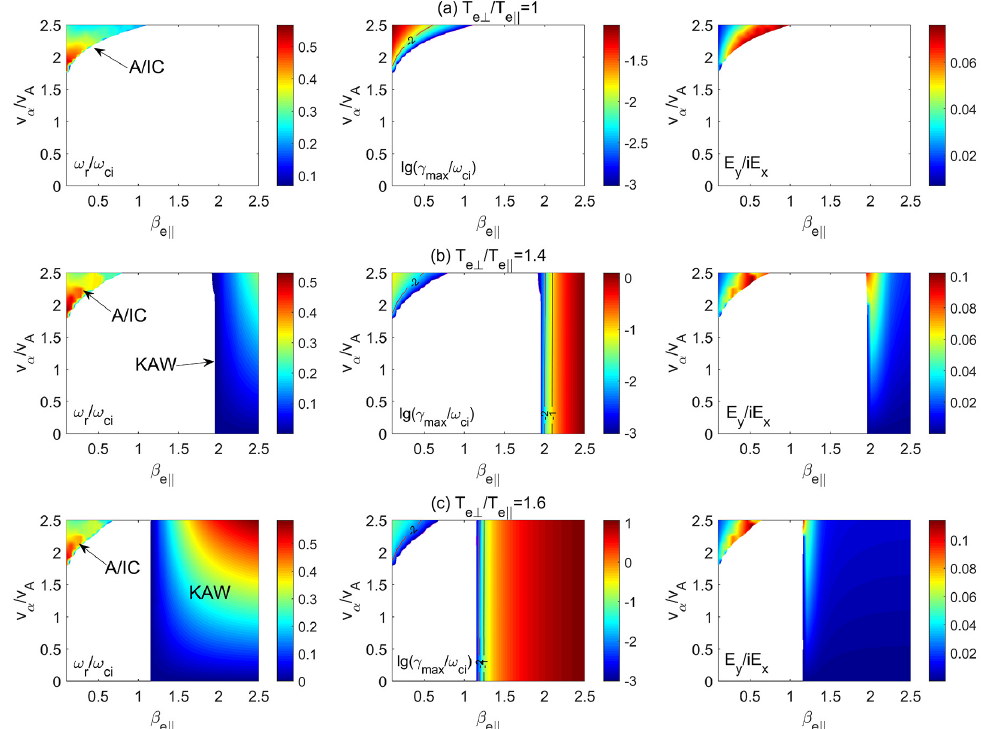
Figure 8. Color bar distributions of the real frequency ( ω r / ω ci ), maximum growth rate ( γ max / ω ci ), and polarization ( E y / iE x ) in the plane of the parallel electron beta ( β e (cid:107) ) and the alpha beam drift velocity ( v α / v A ) at θ = 80 ◦ for ( a ) T e ⊥ / T e (cid:107) = 1, ( b ) 1.4, and ( c )